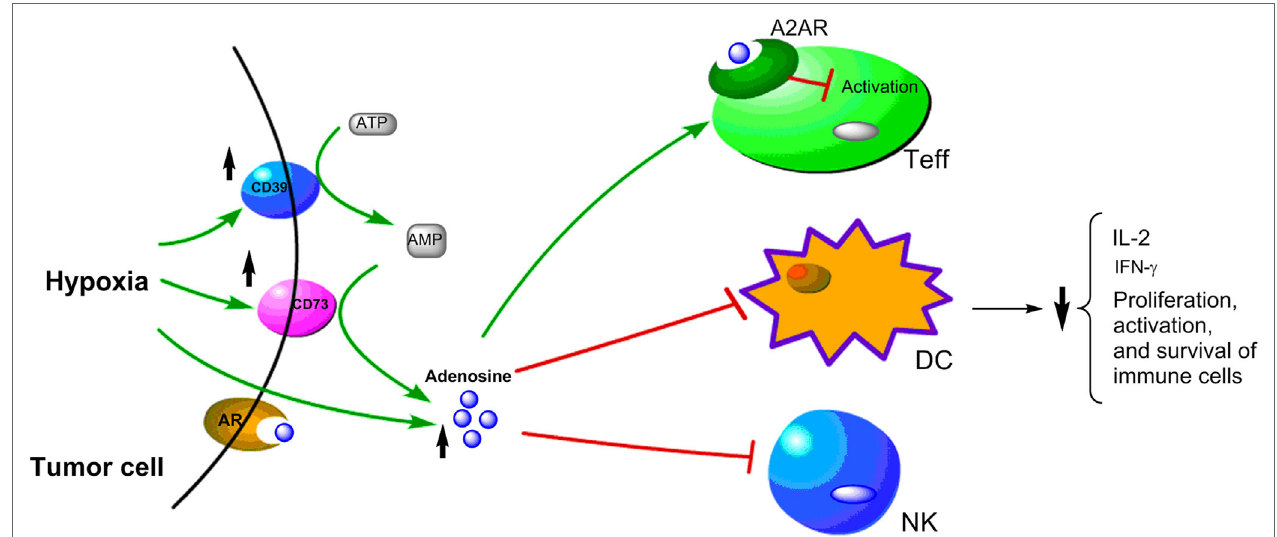
FigURe 3 | Schematic representation of hypoxia upregulating immunosuppressive adenosine signaling pathway in cancer cells. Under hypoxic conditions, the upregulation of CD39 and CD79 expressions lead to increase of adenosine, which has been shown to have immunosuppressive effects on Teff, DC, and NK